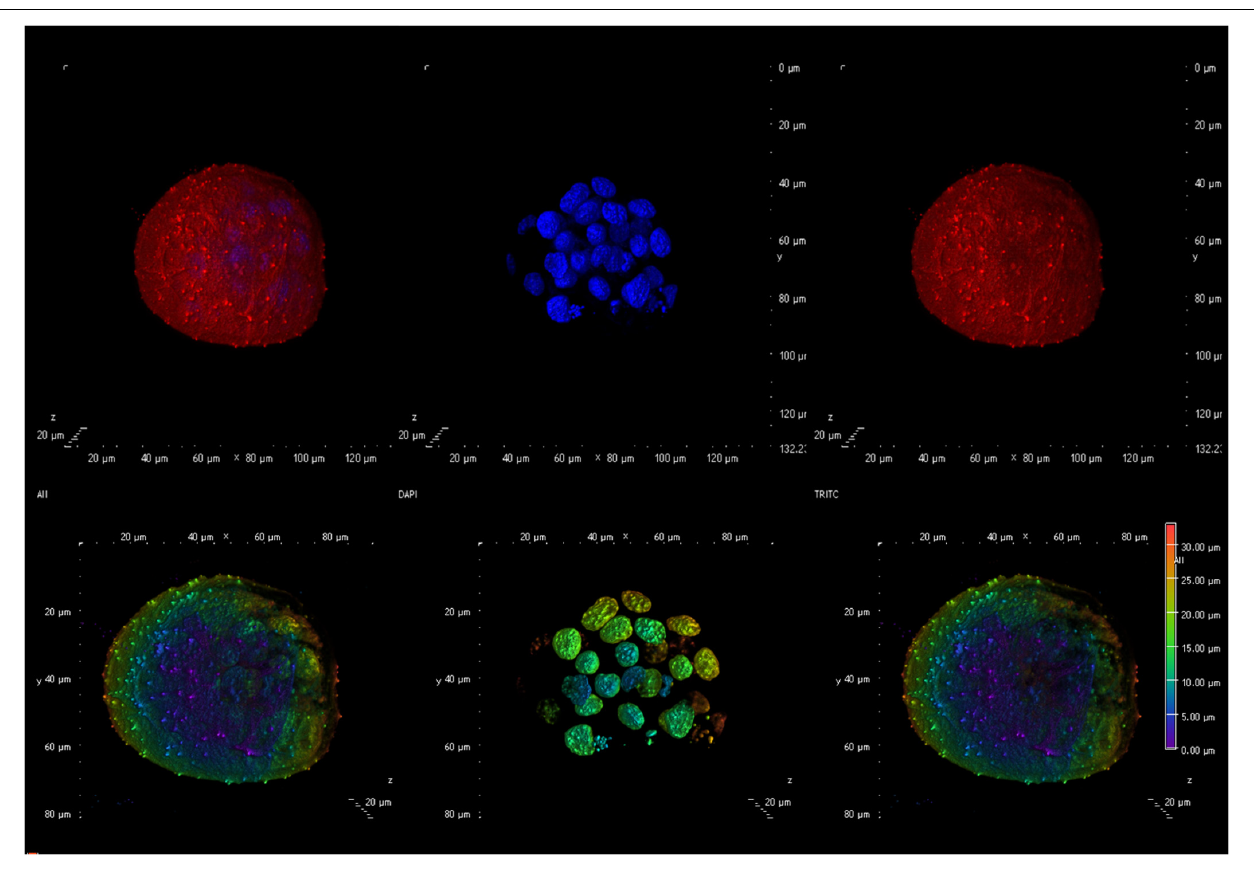
FIGURE 3 | Confocal microscopy image showing an example of an embryo generated using spermatozoa exposed to 0.5 µ g/ml GO. The (upper panel) shows an embryo with (from left to right) an overlay of the membranes in red (DilC12) and the nuclei in blue (DAPI), only the nuclei, only the membranes. The (lower panel) illustrates, from left to right an overlay of nuclei and membrane showing the Depth Coded maxIP (Intensity Projection) gradient visualization (to evaluate the 3D structure).